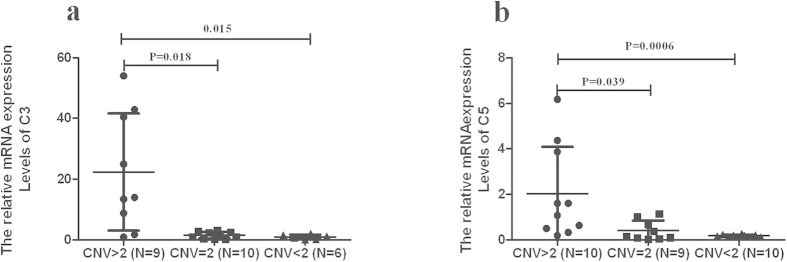
The relationship between the expression of C3 and C5 CNV.mRNA expression of C3 in PBMCs from normal controls with different copy numbers (a) (CNV > 2: n = 9, CNV = 2: n = 10, CNV < 2: n = 6). mRNA expression of C5 in PBMCs from normal controls with different copy numbers (b) (CNV > 2: n = 10, CNV = 2: n = 9, CNV < 2: n = 10). Two independent samples Nonparametric test was used to examine the significance.